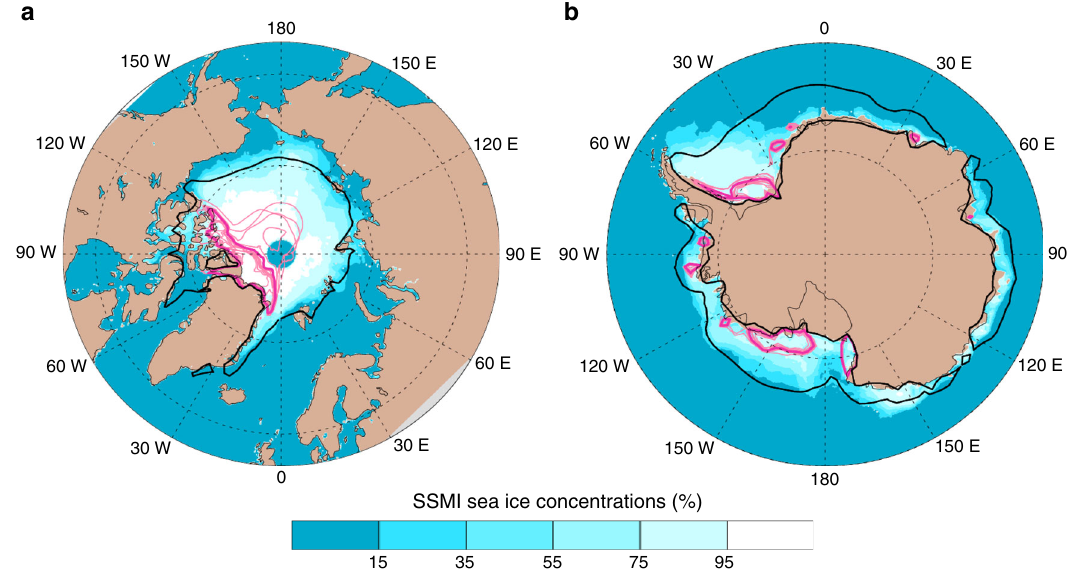
Fig. 1 Impact of sea-ice physics parameter perturbations on Arctic and Antarctic sea-ice cover. a Arctic sea-ice concentrations, September. b Antarctic sea- ice concentrations, March. Shown are monthly mean sea-ice concentrations. Areas contained within contour lines have sea-ice fractions larger than 15%. Thick black lines denote control ensemble means, thick purple lines show “ low Arctic ice ” in a and “ low Antarctic ice ” ensemble means in b . Thin purple lines indicate individual “ low Arctic ice ” ( “ low Antarctic ice ” ) simulations. The colored shading indicates the average observed September ( a ) and March ( b ) sea-ice concentrations over the period 1992 – 2001 (from the Center for Satellite Exploitation and Research; http://nsidc.org/data/sipn/data-sets. html#seaice-conc-ext). A brief comparison of Arctic vs. Antarctic sea-ice changes is provided in Supplementary Note